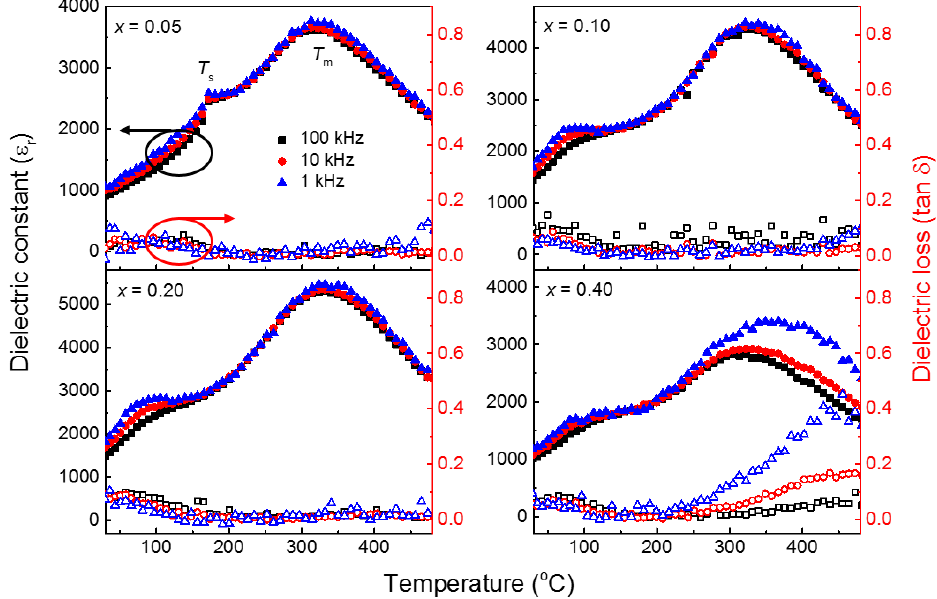
Figure 5. Temperature-dependent dielectric constant ( ε r ) and loss tangent (tan δ ) of BNKT ceramics for measuring frequencies of 1, 10, and 100 kHz.